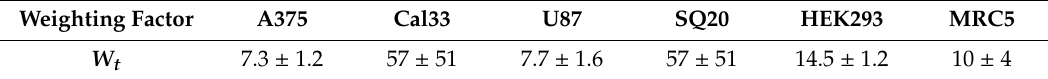
Table 4. Constant weighting factors, W t , of the simplified iso-e ff ective formalism [7]. Weighting